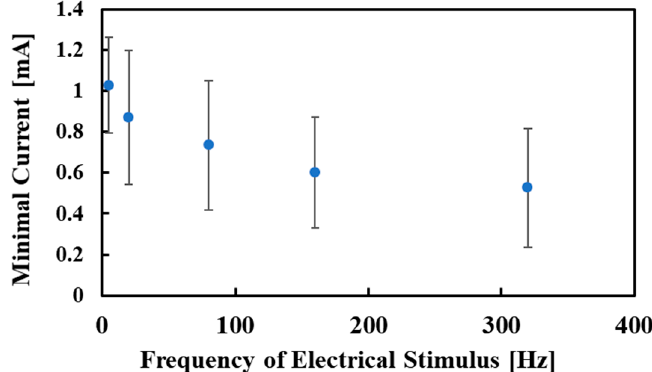
Figure 8. The relationship between the frequency of the electrical stimulus and the minimal current. The minimal current decreased with a decrease in the frequency. The minimal current was also affected by the frequency.